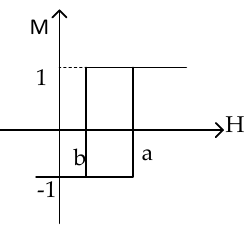
Figure 2. The geometric interpretation of the Preisach model.